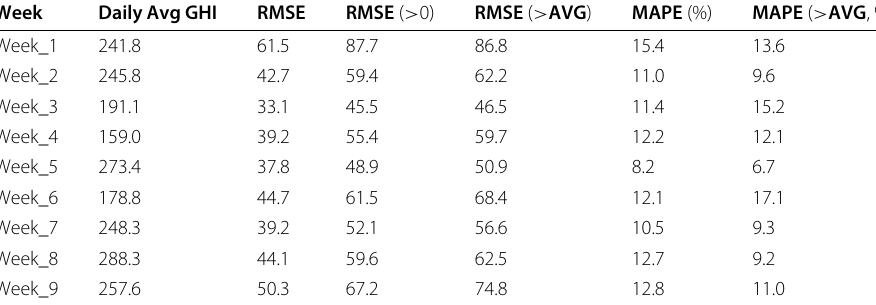
Estimation of global